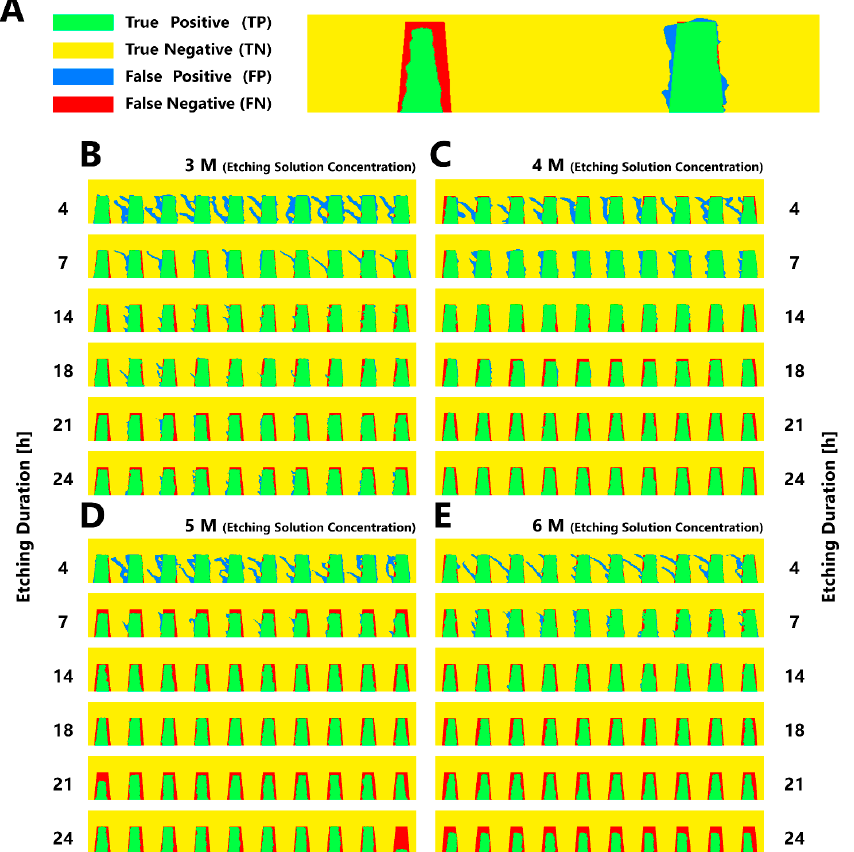
Figure 4. Image analysis procedure using MNA photos aligned with their corresponding CAD for purpose of extracting similarity indices. ( A ) Upon alignment of each experimental image to its corresponding CAD, a code was developed for extraction of several similarity metrics. The total instances which included 240 cases, were converted into binary and their pixels were compared, giving a set of TPs, TNs, FPs, and FNs. A pixel was considered to be “positive” if it belonged to a MN, otherwise it was considered to be “negative”. Also, pixels were considered as “true” if they had the same binary values in both images, otherwise they were considered as “false”. Example image analysis results for one of the studied designs (Case 8 from Table 1), exposed to KOH etching in four concentrations of ( B ) 3 M, ( C ) 4 M, ( D ) 5 M, and ( E ) 6 M, for six durations (4, 7, 14, 18, 21, and 24